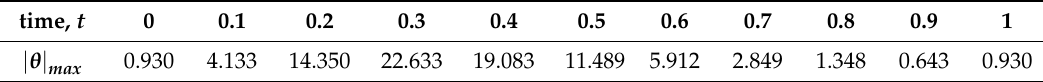
Figure 3. Disturbance isotherms corresponding to critical conditions, namely k = k c and Ra = Ra c , and over one forcing period. Table 3. Values of |𝜽| 𝒎𝒂𝒙 for each thermal disturbance field shown in Figure 3.